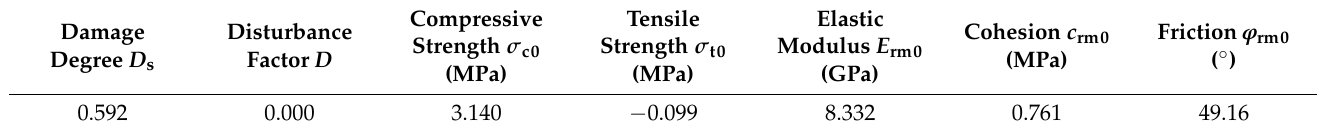
Table 5. Mechanical properties of the undisturbed rock mass.